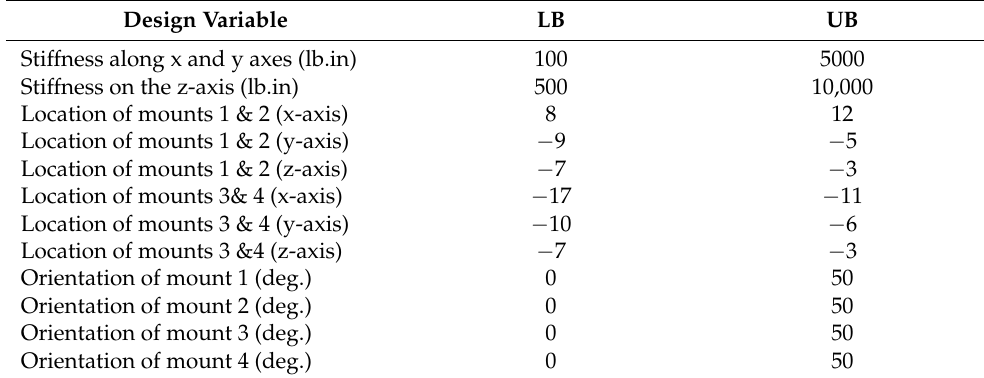
Table 2. Upper and lower bounds of the design variables.